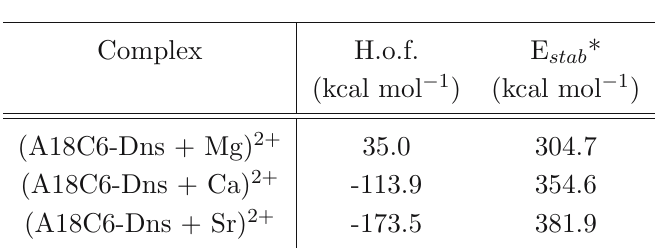
Table 3 Heats of formation (H.o.f.) and stabilization energies (E stab ) for the complexes between A18C6-Dans and Mg 2+ , Ca 2+ , Sr 2+ .